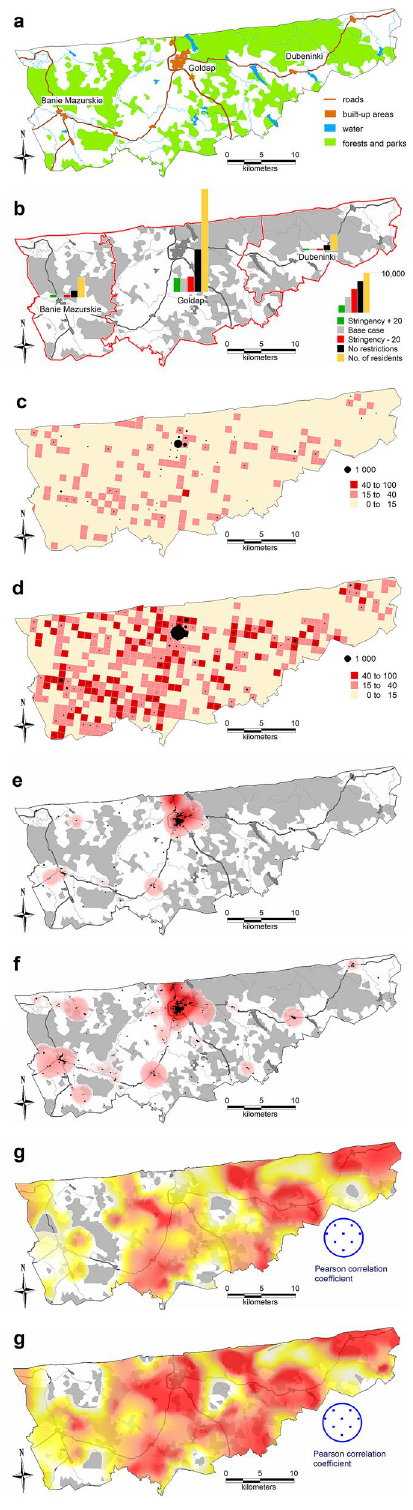
Figure 10. Spatial distributions of the numbers of cases, their locations, and the differences between the individual models in the Gołdap powiat. ( a ) Gołdap powiat: land cover. ( b ) The number of cases in the 4 models in the gminas in relation to the number of inhabitants of these gminas. ( c ) The number of cases in a 1 × 1 km grid (pie chart) and the percentage of cases (intensity of red color): Stringency Index − 20 model. ( d ) The number of cases in a 1 × 1 km grid (pie chart) and the percentage of cases (intensity of red color): No restrictions model. ( e ) The location of cases (black dots) and the density of cases by the place of infection: Stringency Index − 20 model. ( f ) The location of cases (black dots) and the density of cases by place of infection: No restrictions model. ( g ) The Pearson correlation coefficient between place of infection and the number of inhabitants of the area (white < 0.5, yellow < 0.75, red ≥ 0.75): Stringency Index − 20 model. ( h ) The Pearson correlation coefficient between the place of infection and the number of inhabitants of the area (white < 0.5, yellow < 0.75, red ≥ 0.75): No restrictions model (developed by the authors in QGIS ver.